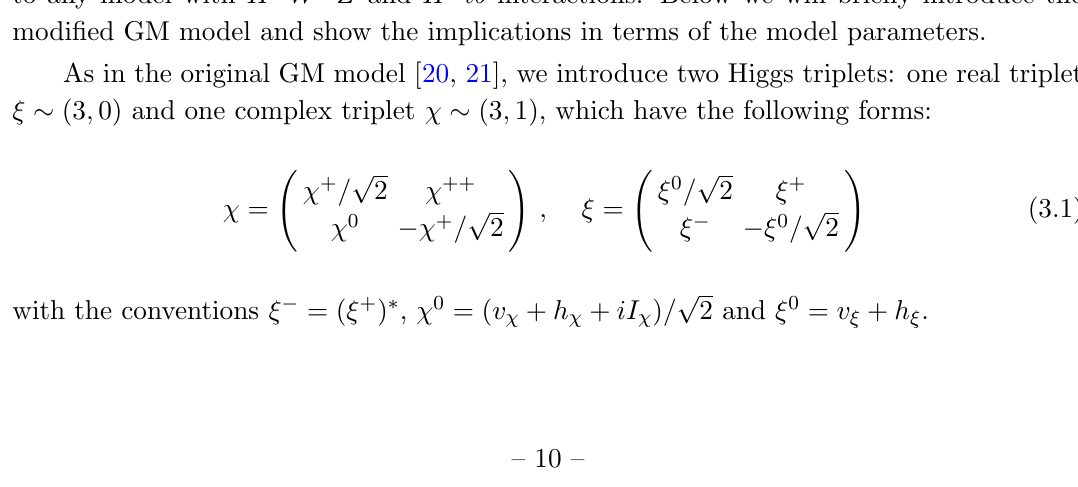
Figure 5 . Sensitivities to the H (cid:6) W (cid:7) Z and H (cid:6) tb couplings for m minimal total width assumption. The blue and green regions are obtained from the exclusion limits at 95% C.L. of the processes pp ! tH (cid:6) , H (cid:6) ! tb and pp ! jjH (cid:6) , H (cid:6) ! W (cid:6) Z , respectively. The red solid, dashed and dot-dashed curves correspond to the exclusion limits at 95% C.L. and discovery signi(cid:12)cance Z D = 3 ; 5,